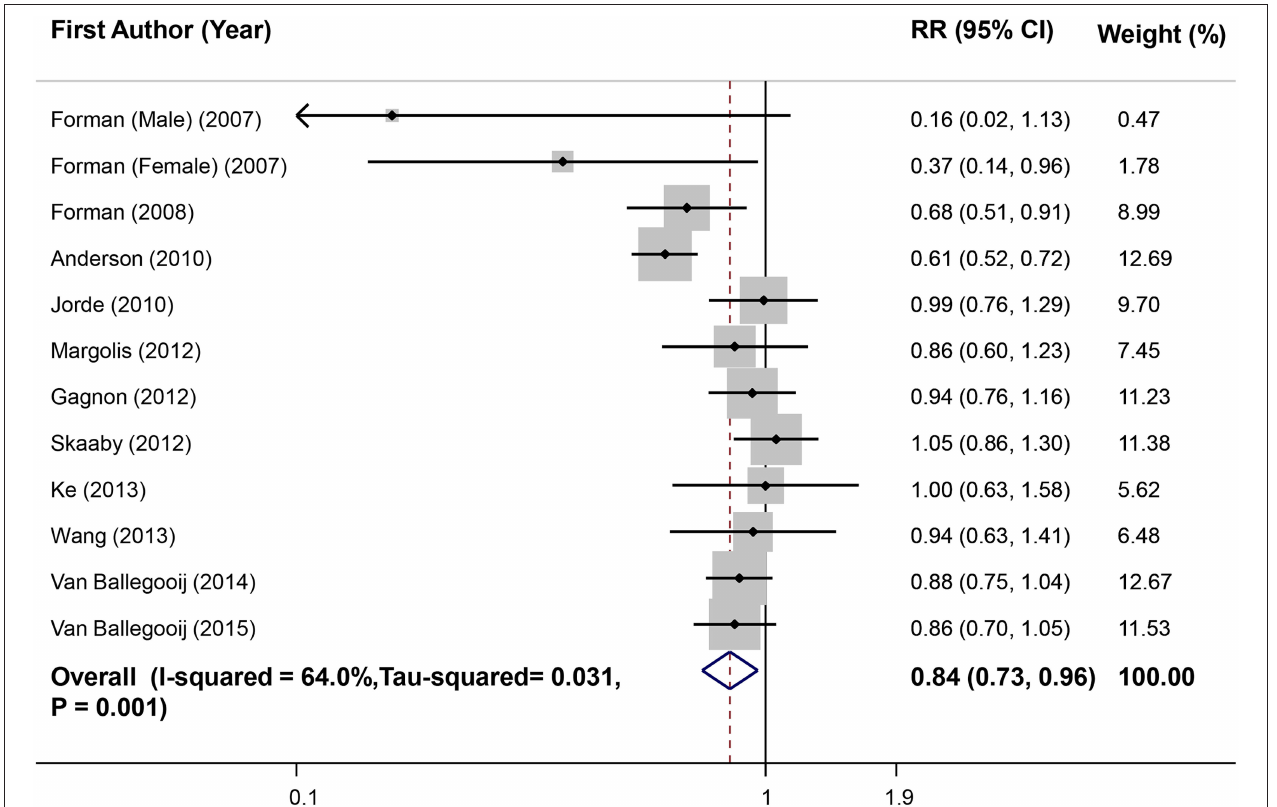
FIGURE 2 | Forest plot of prospective studies that examined the association between highest vs. lowest level of serum vitamin D and risk of hypertension (HTN).